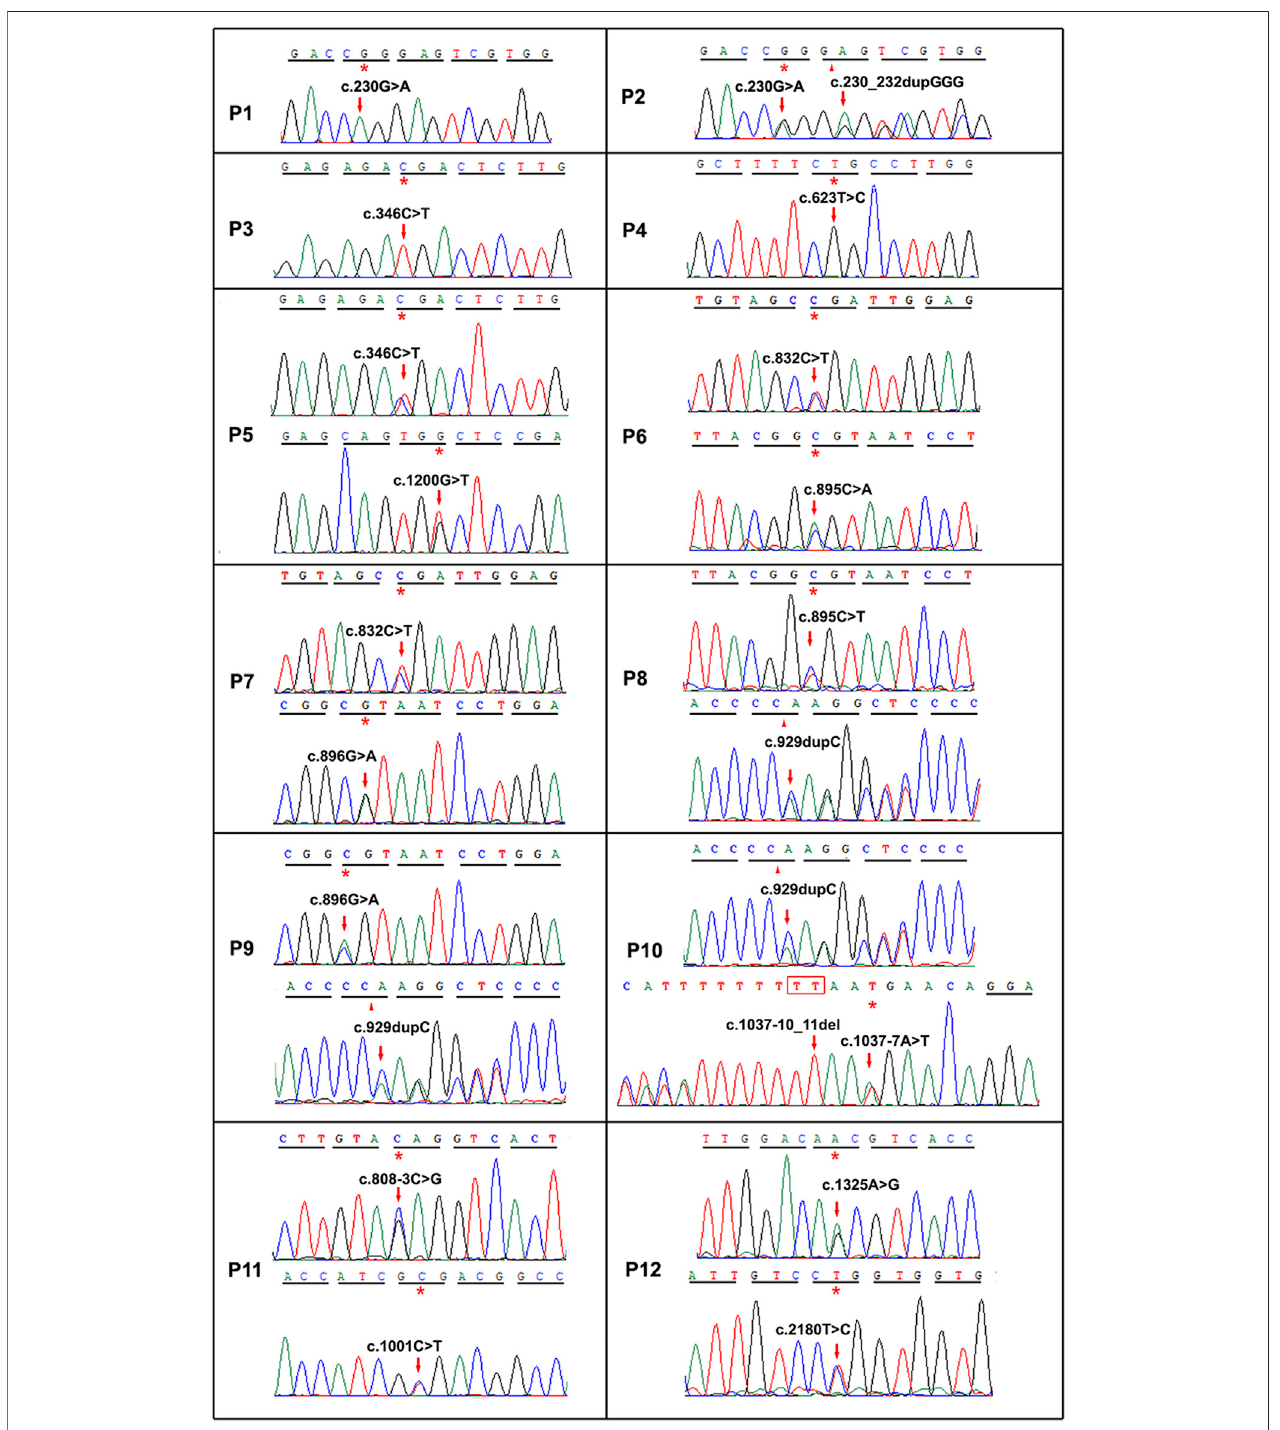
FIGURE2| Sequencechromatogramsof TYR or OCA2 variantsoftwelveOCAcasesinthisstudy.Thenucleotidechangeswerepointedbyredarrows. p ,patient. The fi rst ten cases P1 – P10 related to TYR variants, and the last two cases P11 – P12 related to OCA2 .